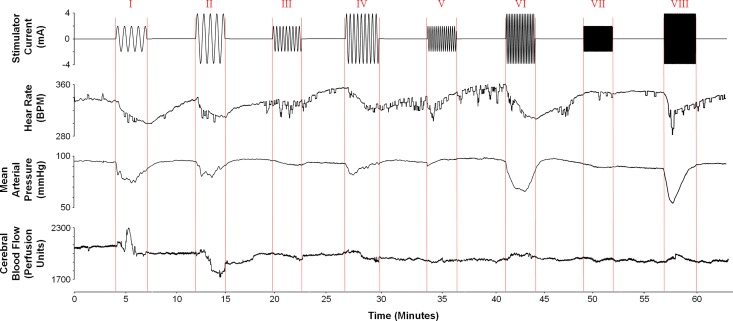
Effects of Various Sets of Stimulation Parameters on HR, MAP, and CBF.A representative plot of the stimulator current (mA), heart rate (BPM), mean arterial pressure (mmHg), and cerebral blood flow (perfusion units) is shown. Baseline data was collected for 4 minutes before beginning stimulation (minutes 0–4). Five minutes of recovery was allowed after each stimulation event. Stimulation occurred for 3 minutes using eight different sets of stimulation parameters: 2 mA at 0.025 Hz (I), 4 mA at 0.025 Hz (II), 2 mA at 0.05 Hz (III), 4 mA at 0.05 Hz (IV), 2 mA at 0.1 Hz (V), 4 mA at 0.1 Hz (VI), 2 mA at 0.5 Hz (VII), and 4 mA at 0.5 Hz (VIII). Red lines highlight the start and stop of each stimulation event. The greatest drop in CBF (13.9%) occurred for the 4 mA, 0.025 Hz current (II).